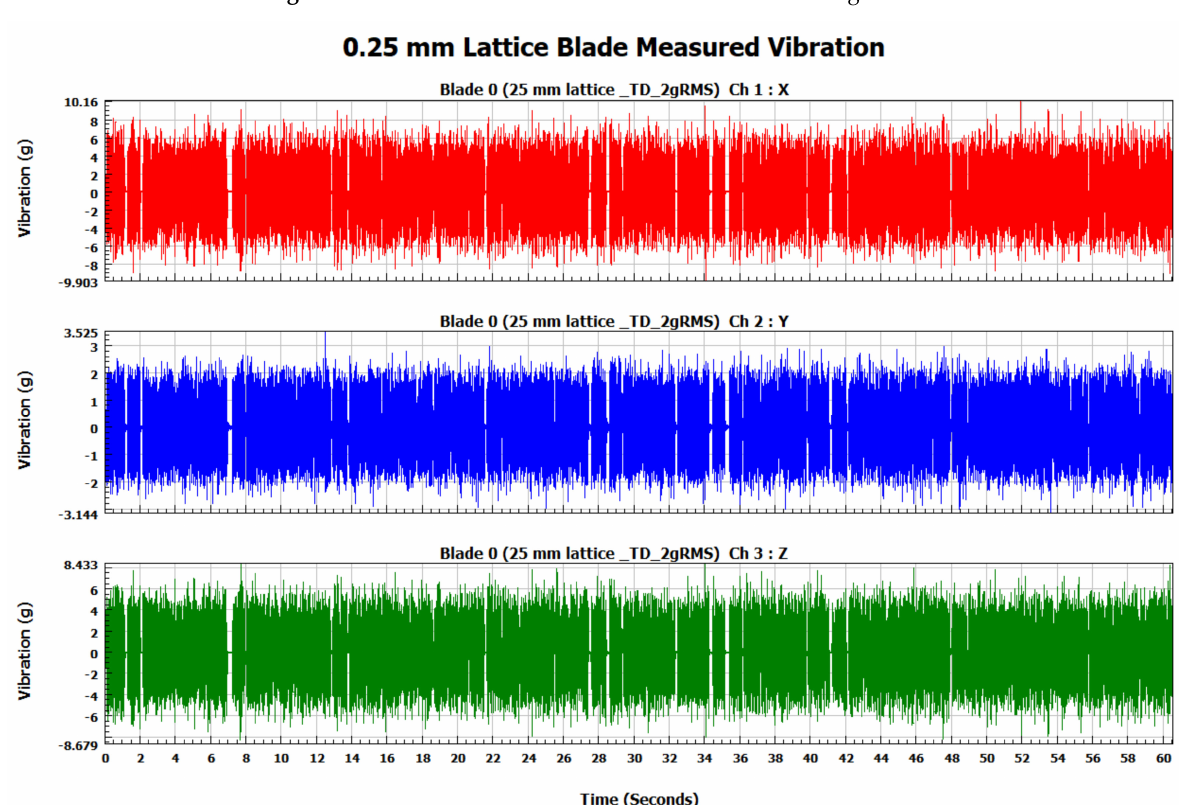
Figure 13. The 0.25 mm lattice blade measured vibration signal in the time